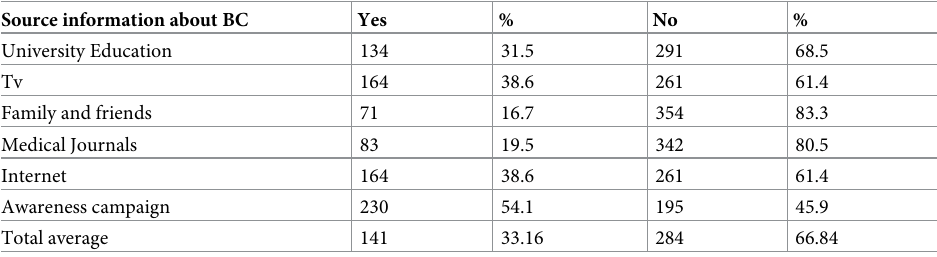
participants understood that obesity, lack of exercise, smoking and X-rays increase the risk of breast cancer. They also had average knowledge of the signs and symptoms of breast cancer; 79.8%, 63.5% and 53.4% of the participants, respectively, knew that changes in breast and nip- ple shape, size and colour, lumps in the breast and discharge from the nipple are among the signs and symptoms of breast cancer. Also, 96.9% of the participants knew that early detection of breast cancer leads to improve treatment outcomes (Table 4). Table 2. Respondents’ source information about breast cancer.